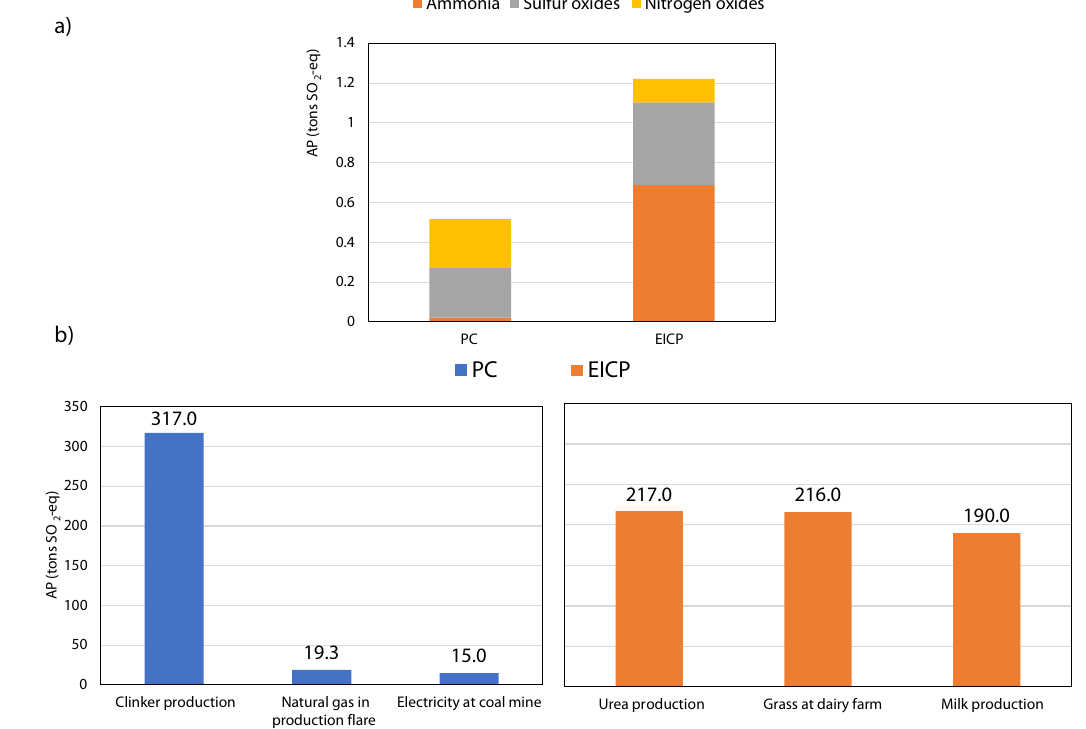
Figure 3. Acidification potential of the PC and EICP soil stabilization techniques: ( a ) total and individual emissions, and ( b ) highest contributing